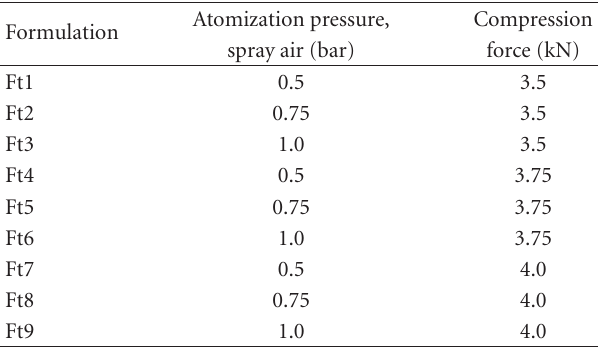
Table 4: Experimental plan for the second set of